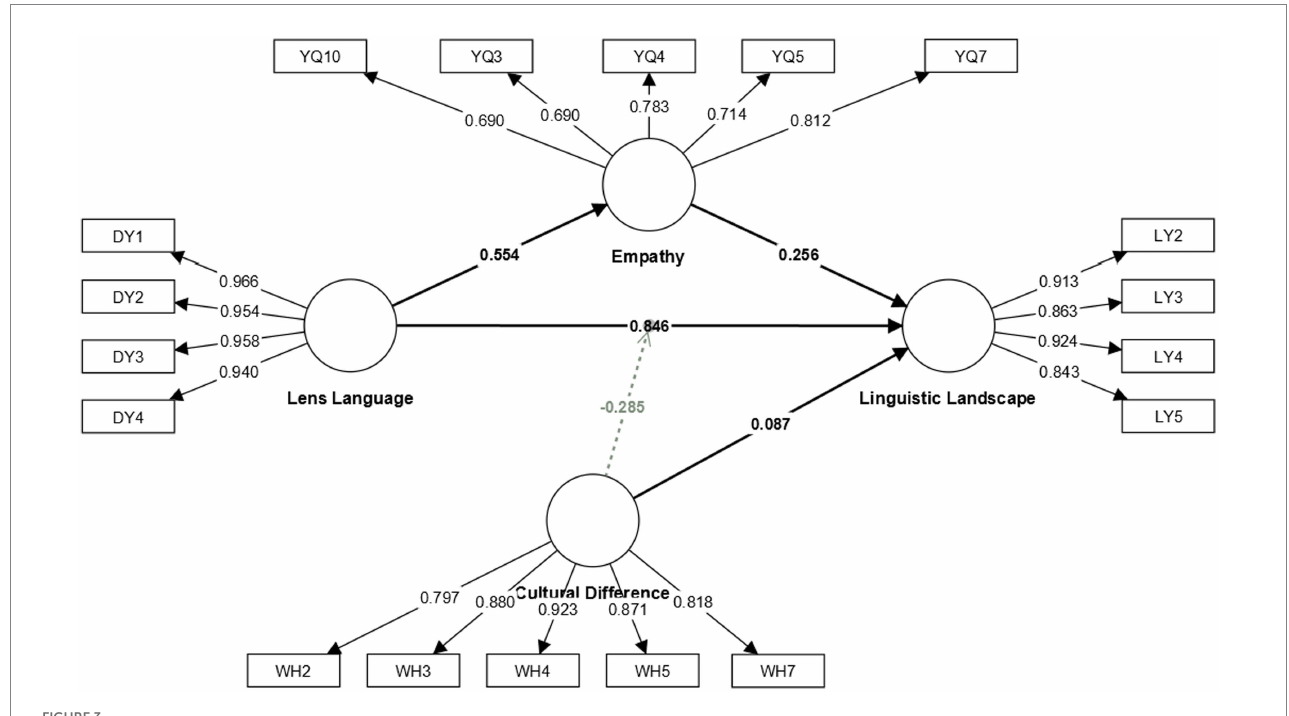
FIGURE 3 Construction of structural equation model.